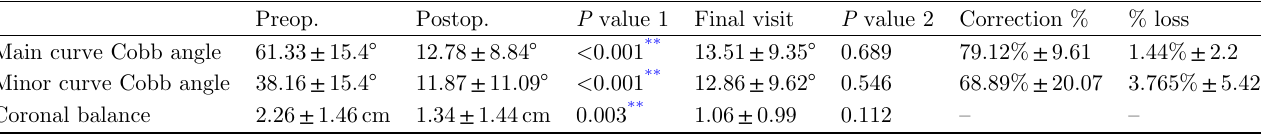
Table 2. Coronal parameters.